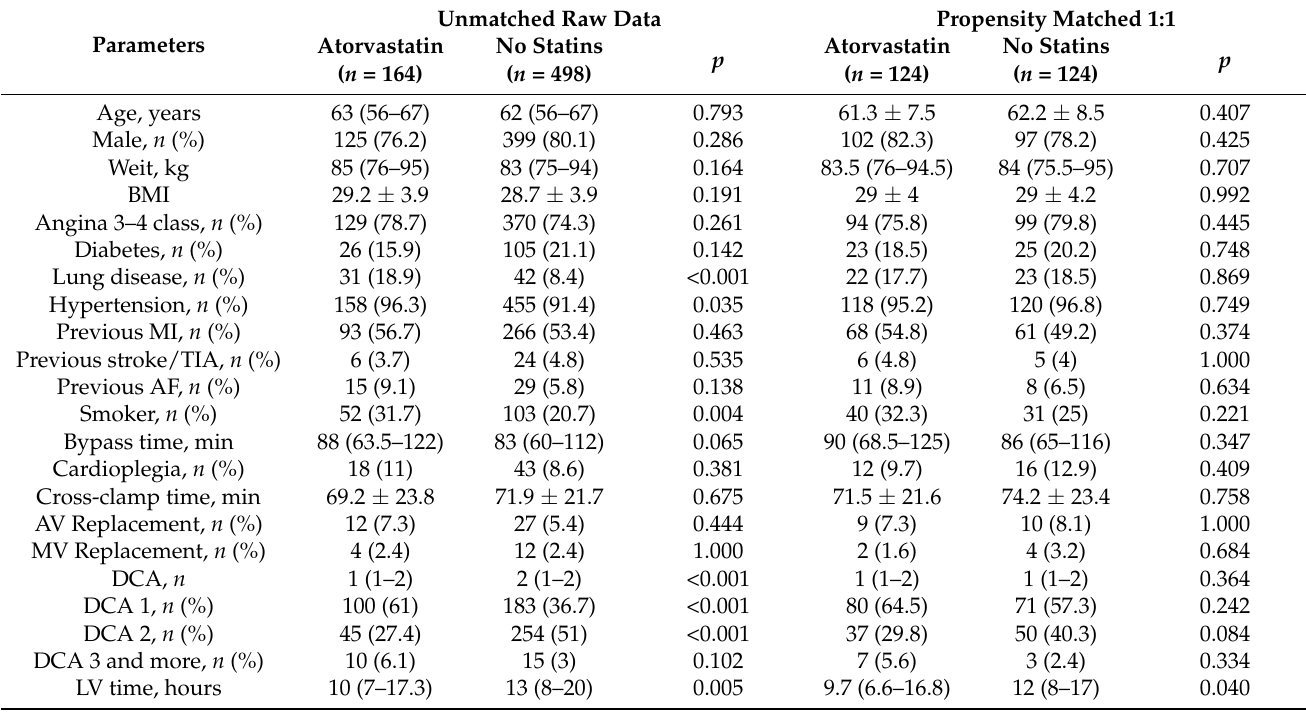
Table 4. Clinical data and operative